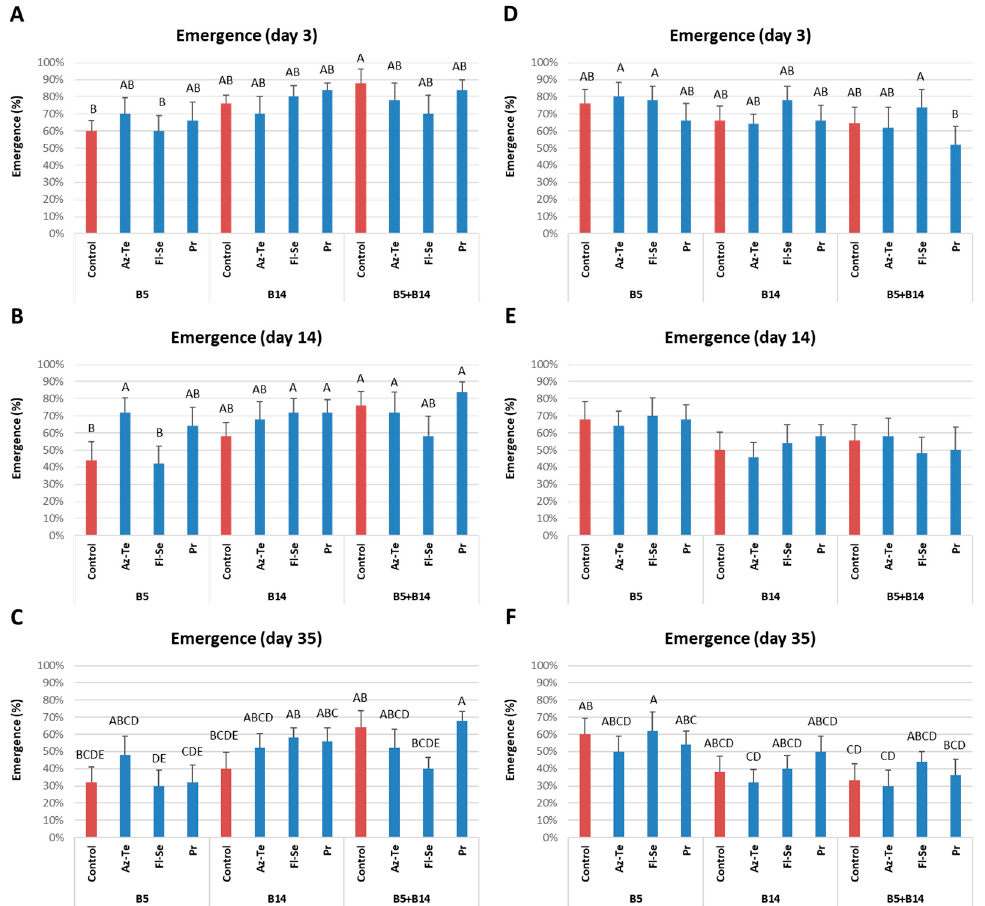
Figure 3. The effect of chemo-pesticide treatments on the emergence and survival of white onion plants (Orlando cv., A–C ) and red onion plants (Noam cv., D–F ) 4, 14, and 35 days after the beginning of the soil surface appearance. B5- F. acutatum , B14- F. oxysporum f. sp. cepae . The experiment and abbreviations are described in Figure 2. Bars indicate the mean of 10 biological replications (pots). Controls (red columns) are plants without fungicides. Error bars are standard errors. If it exists, different letters (A–E, above the chart's bars) represent a significant difference ( p < 0.05) in the ANOVA test.